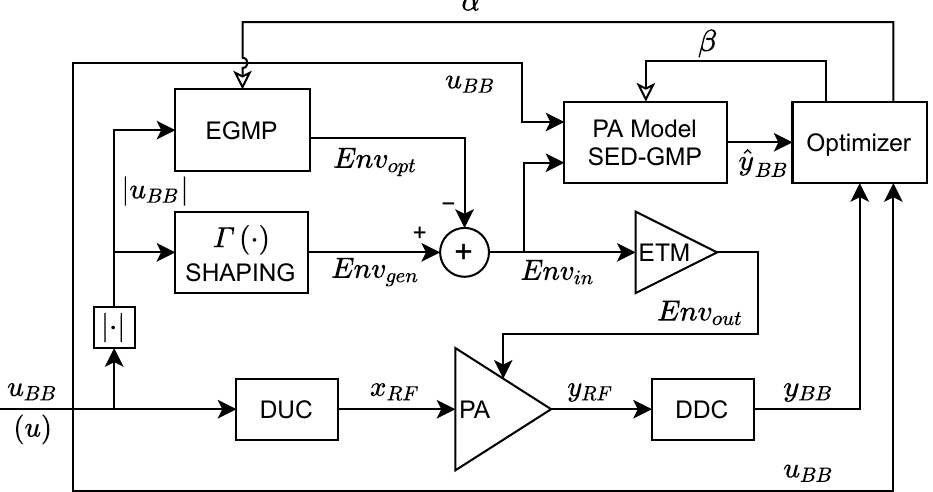
Figure 7. Block diagram of the optimized envelope generation scheme, the measurement of Env out is not required by the